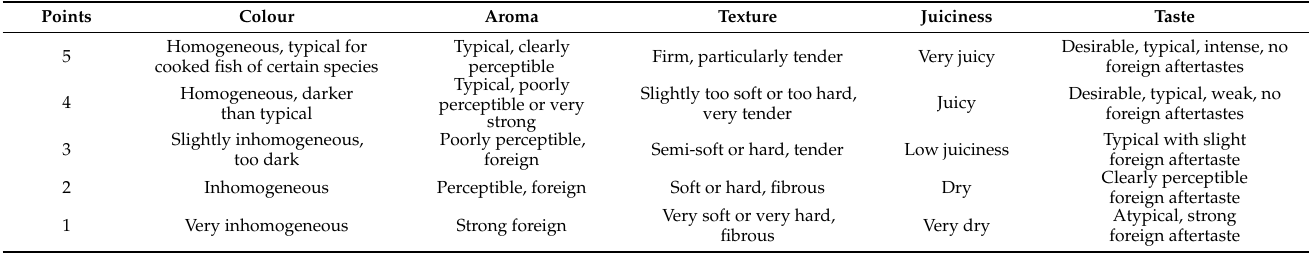
Table 1. Sensory analysis description and scores used in sous vide cooked pikeperch fillets evaluation.